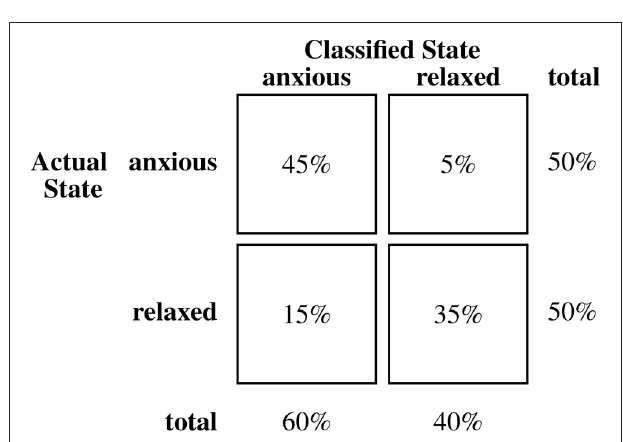
FIGURE 4 | Confusion matrix for classifications of biomusic from typically developing children (Stroop) in Experiment